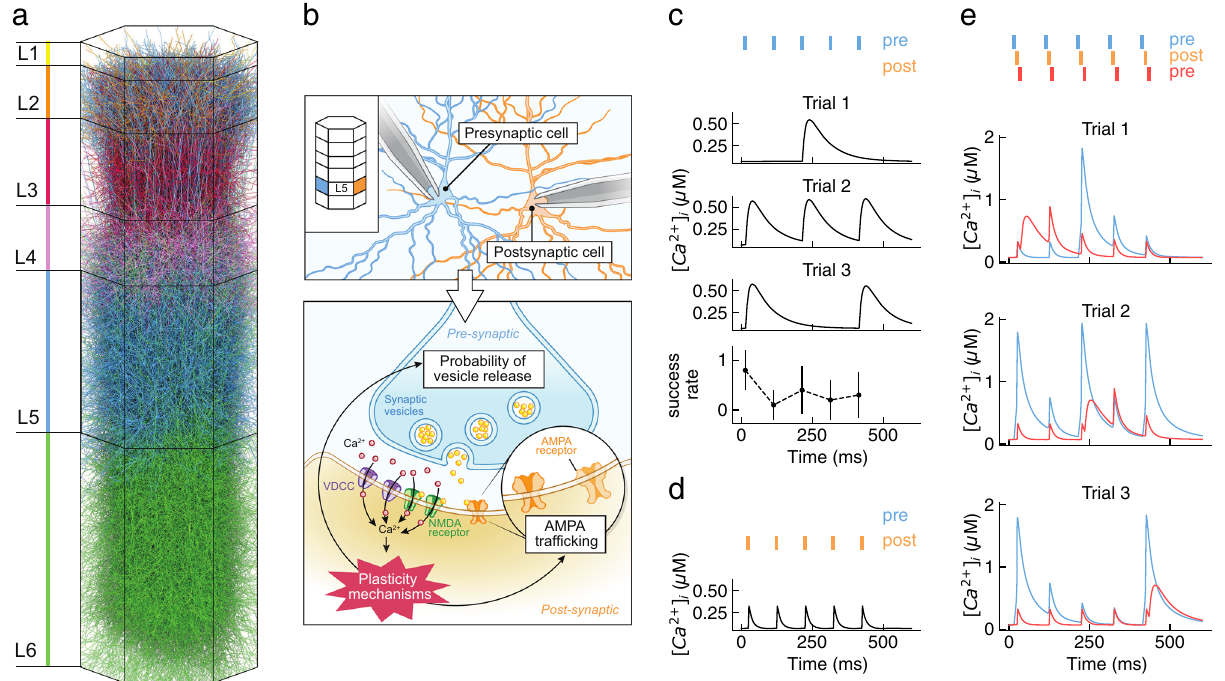
Fig. 1 Modeling the role of postsynaptic calcium in LTP/LTD. a A 3-D rendering of a neocortical column in the circuit model used in this study. Neuronal morphologies are colored according to their layer of origin (axons not shown). b Schematic of the main players and events contributing to LTP/LTD induction at excitatory synapses (bottom) between pyramidal neurons (top). Pre-synaptic vesicle release and subsequent post-synaptic depolarization results in calcium in fl ux in dendritic spines via NMDARs and VDCCs. Calcium signaling activates independent biochemical pathways, leading to